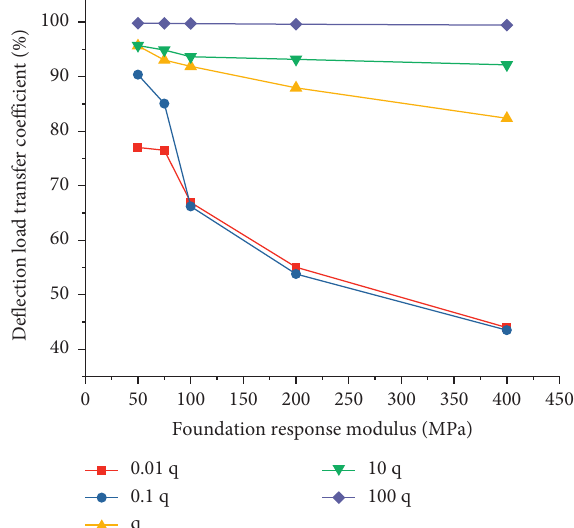
Figure 11: Variation of deflection load transfer coefficient with respect to the elastic modulus of the foundation ground under different values of spring